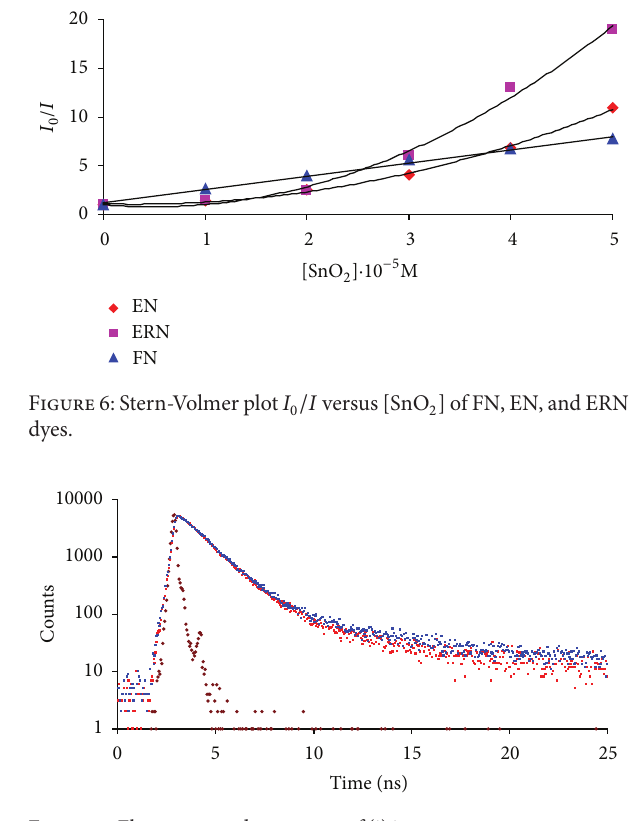
Figure7:Fluorescencedecaycurveof(i)instrumentresponsecurve (Brown color decay), (ii) EN ( 4 × 10 −6 M; red color), and (iii) EN in the presence of colloidal SnO 2 ( 5 × 10 −4 M; blue color).